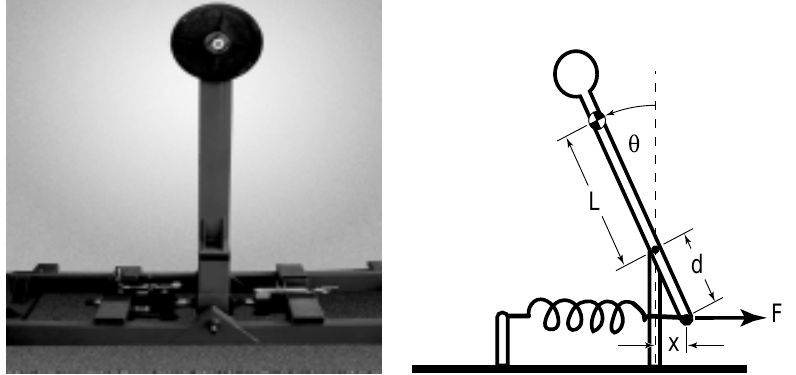
Fig. 6. Photo and schematic diagram of pendulum-like test apparatus. The unit is approximately 5 feet tall and the upper mass weighs approximately 100